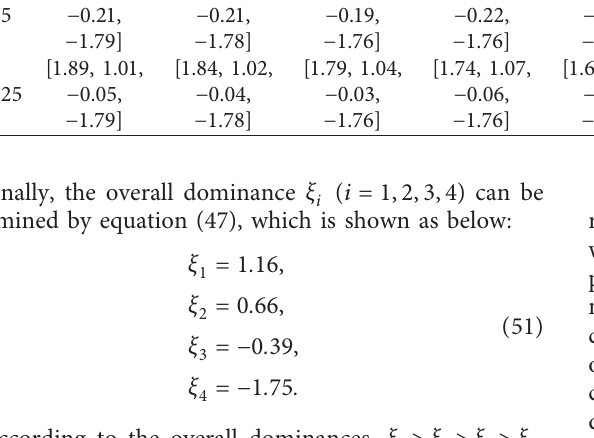
Table 6: The overall dominance values of risk levels with different values of α and θ in case of q � 2. ξ i α � 0 .